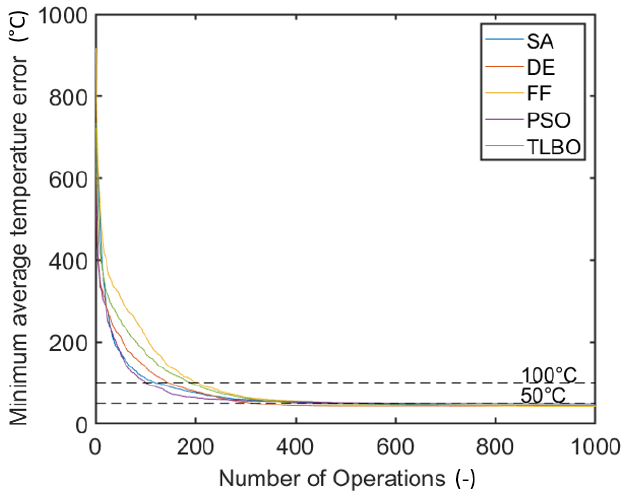
Figure 10. The averaged minimum temperature error reached by the algorithm to particular oper- ation.